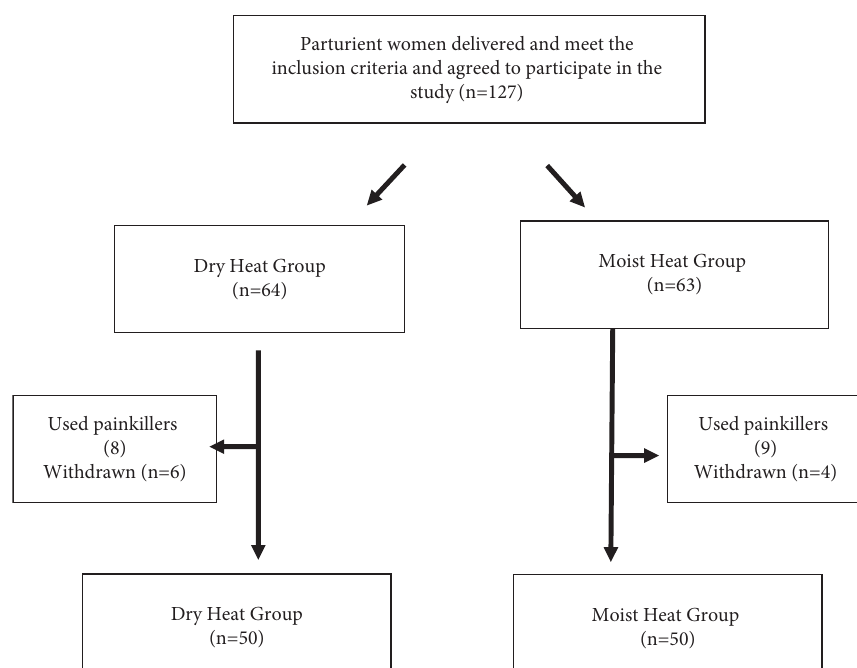
Figure 1: Flow chart of participants’ recruitment